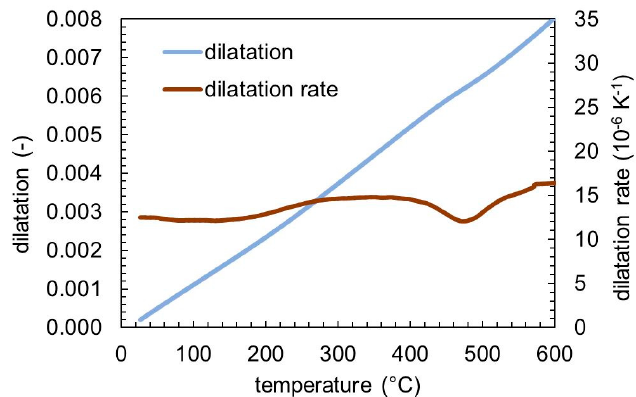
Figure 9. Dilatation and dilatation rate of SAE H13 during tempering with a heating rate of 5 K min − 1 .